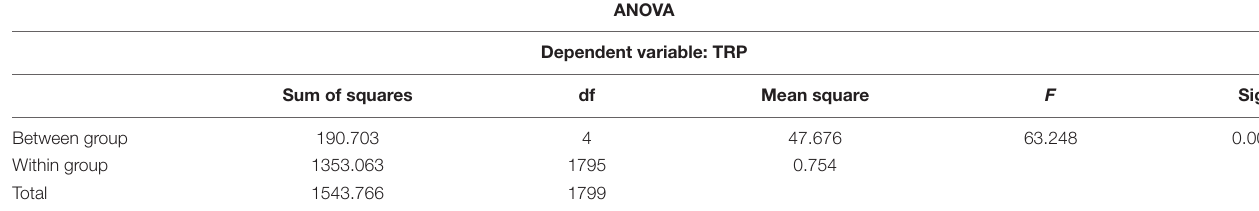
TABLE 4 | TRP ANOVA in different design activities.